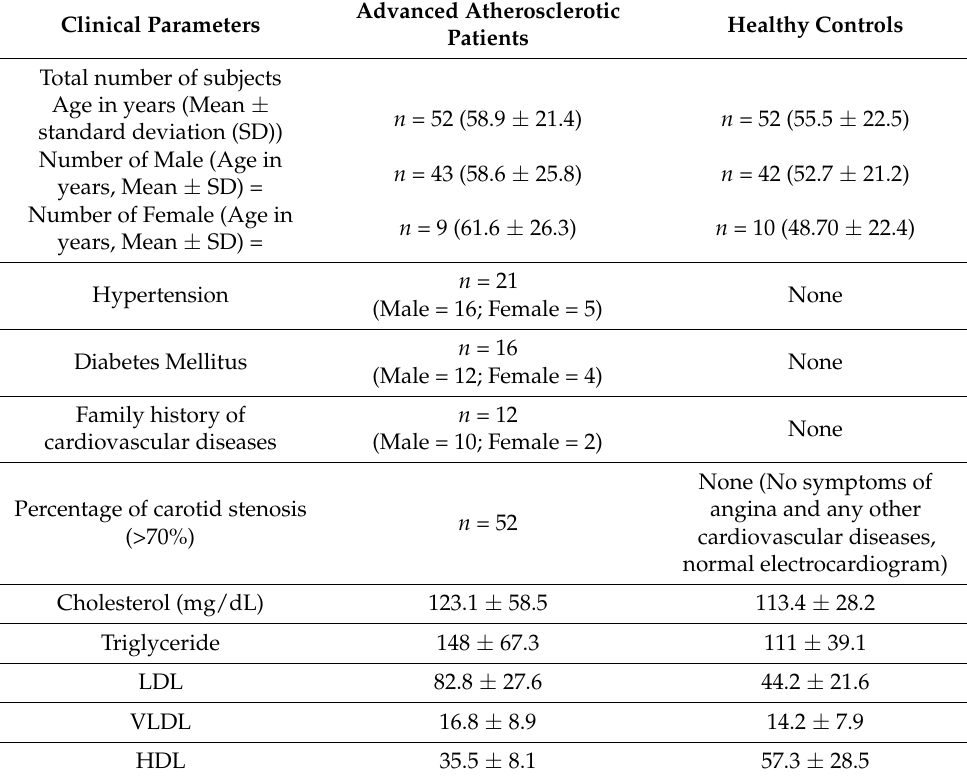
Table 1. Demographic detail of the patient and control groups. Clinical